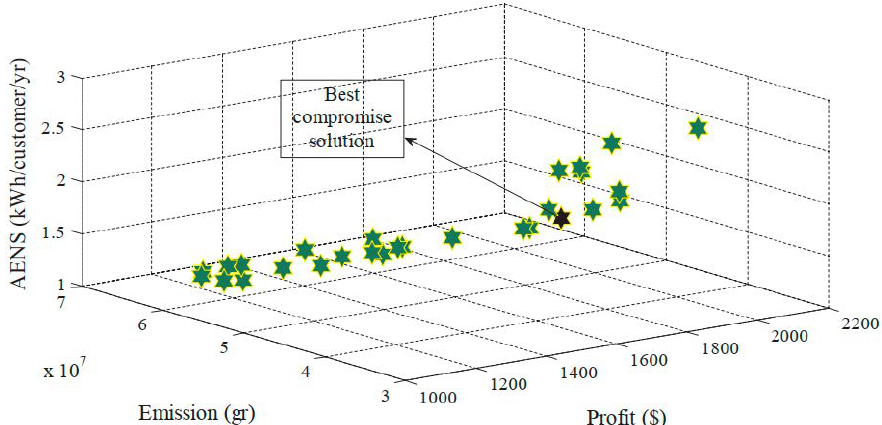
Figure 12. Selecting the best compromise solution, considering the best values for the market profit, total emission production, and average energy not supplied of a CHP-based microgrid [177].